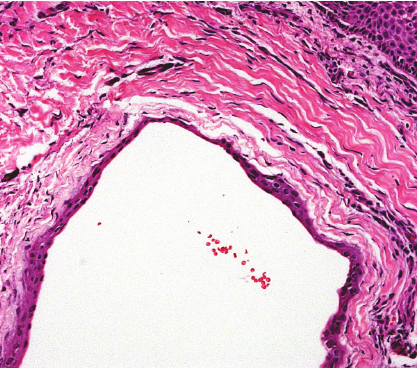
Figure 3: Cystic cavity lined by a thin and flattened epithelial lining.